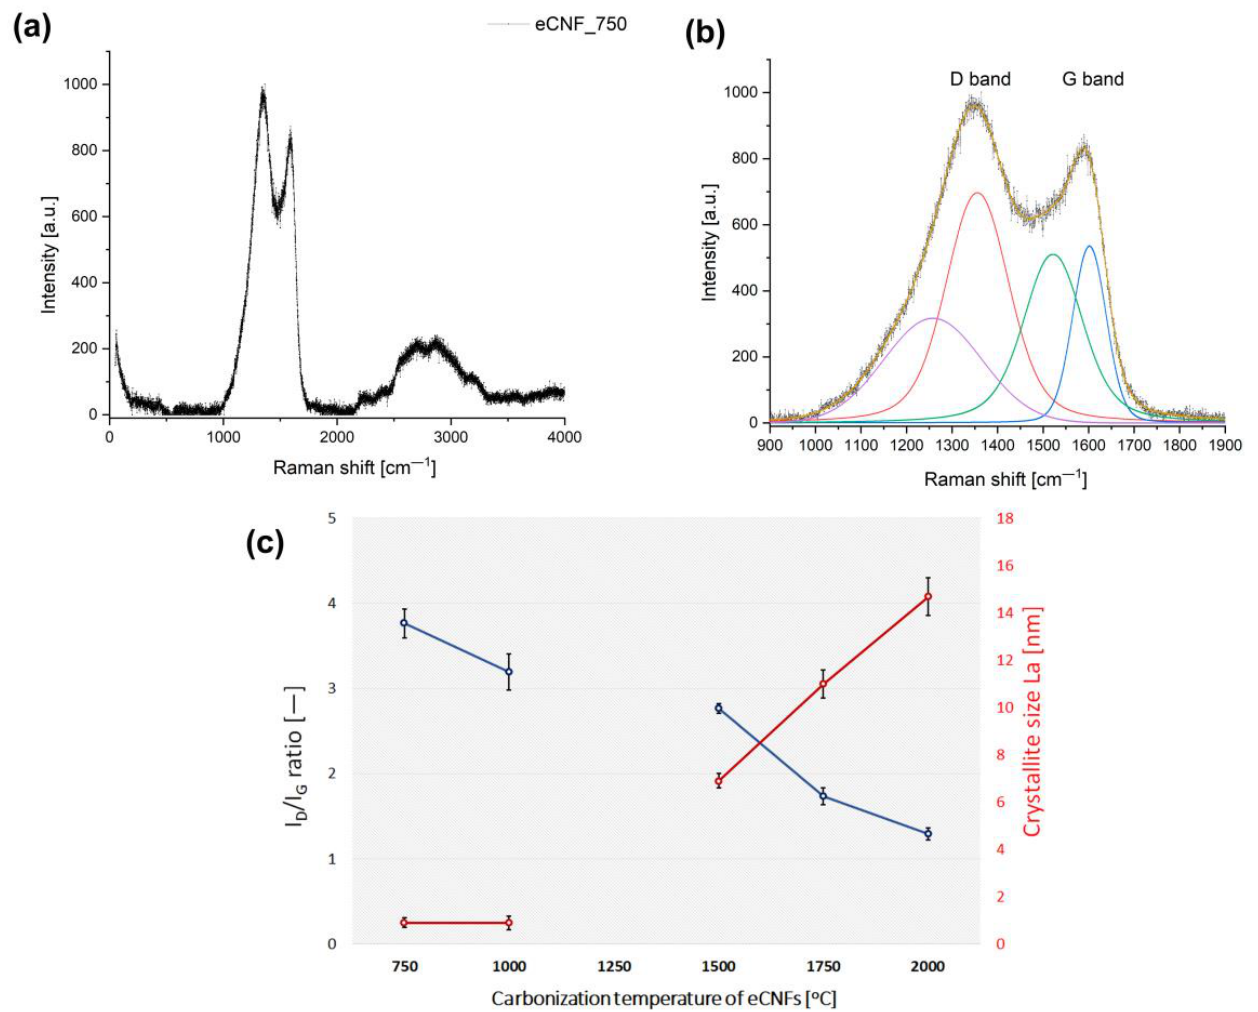
Figure 3. Raman spectrum for the eCNF_750 sample in full range ( a ) and the Raman spectrum of the same sample for the range of primary D and G bands subjected to deconvolution ( b ). Two parameters I D /I G and La extracted from the Raman spectra and estimated from Cançado equation for CNFs obtained at different temperatures ( c